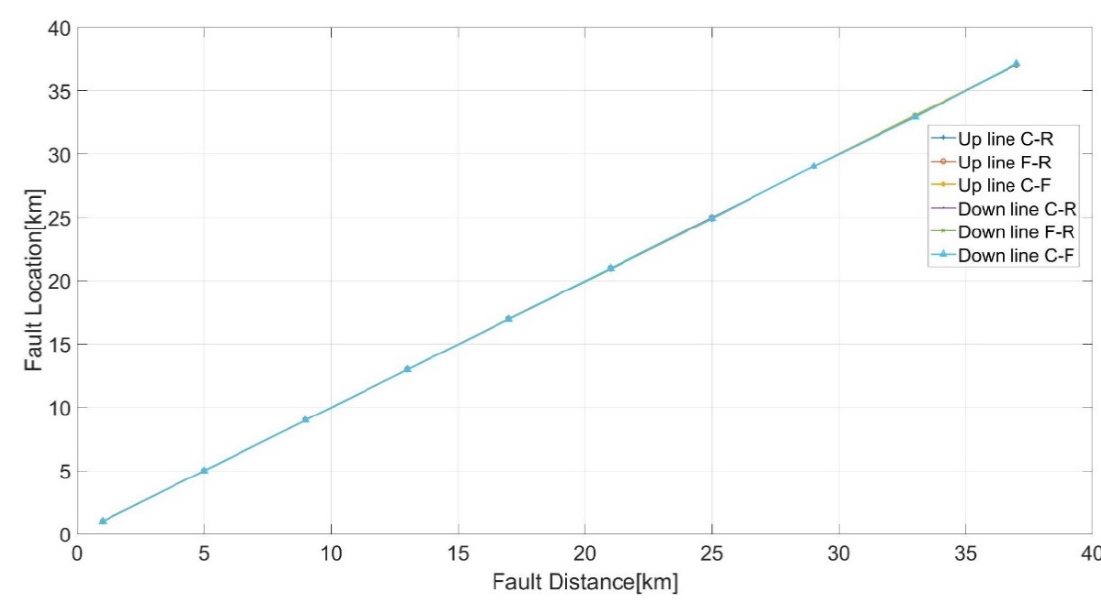
Figure 11. Fault location results vs. fault distance.